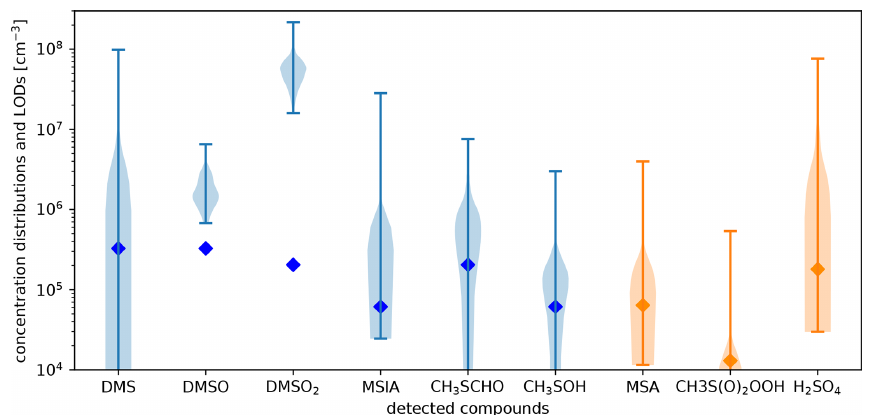
Figure C3. Observed gas-phase organosulfur compounds from the PTR3 (blue) and nitrate-CIMS (orange) with their (lower-limit) concen- tration distributions (violins) and limit of detections (LODs,